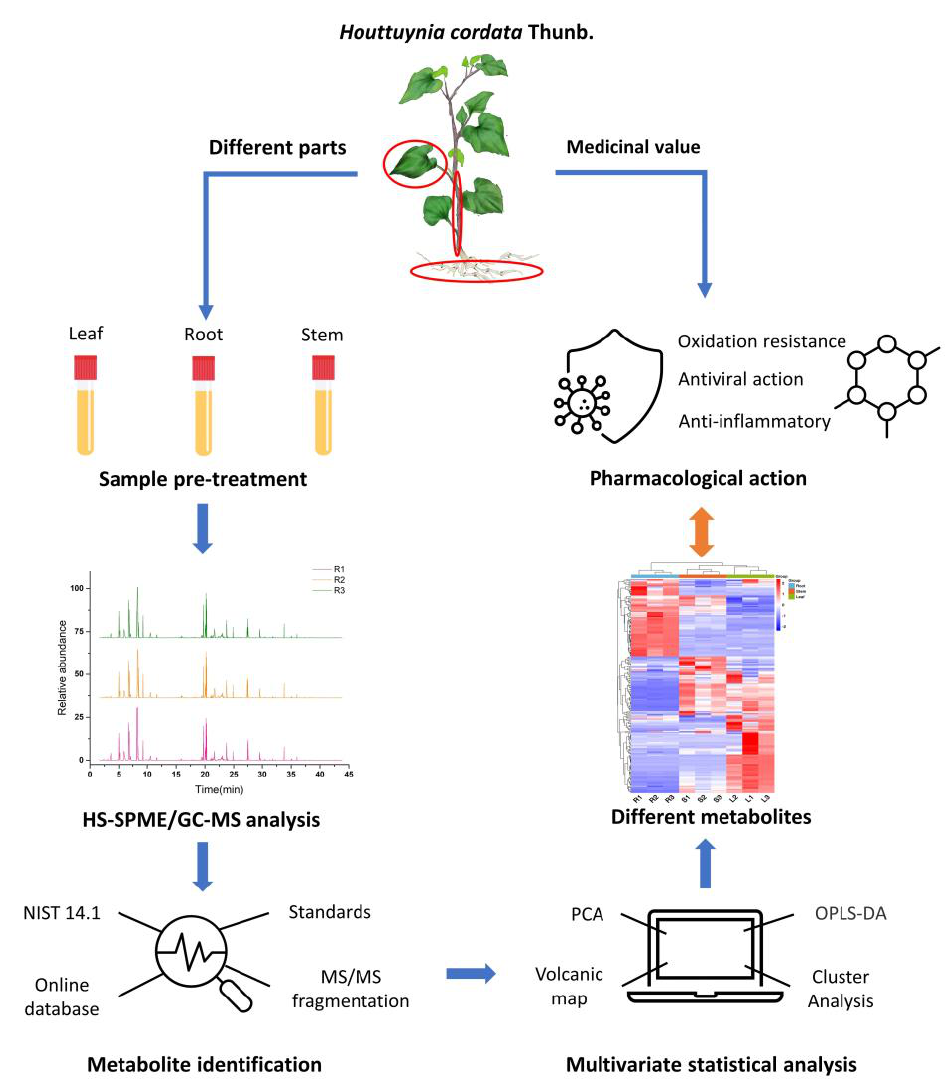
Figure 10. Flow chart of Houttuynia cordata test.